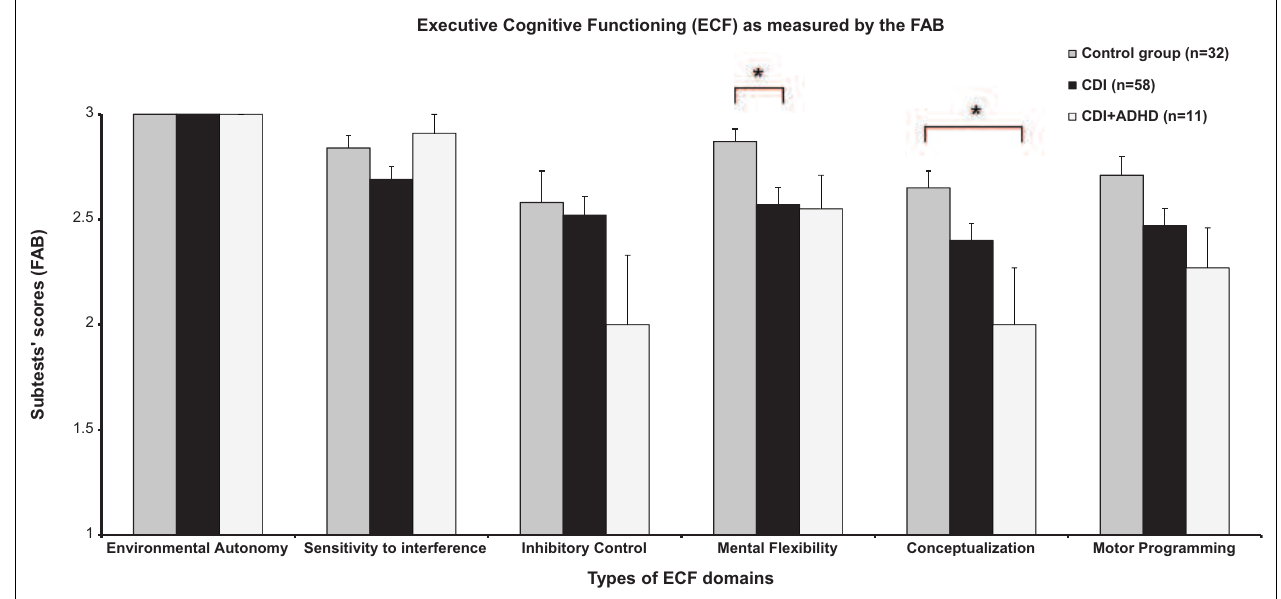
hyperactivity disorder; FAB, Frontal Assessment Battery; ECF, executive cognitive functioning; [*] indicate ECF domains significantly different between groups by ANOVA ( p < 0.05); vertical lines represent standard errors SE ( ± ).